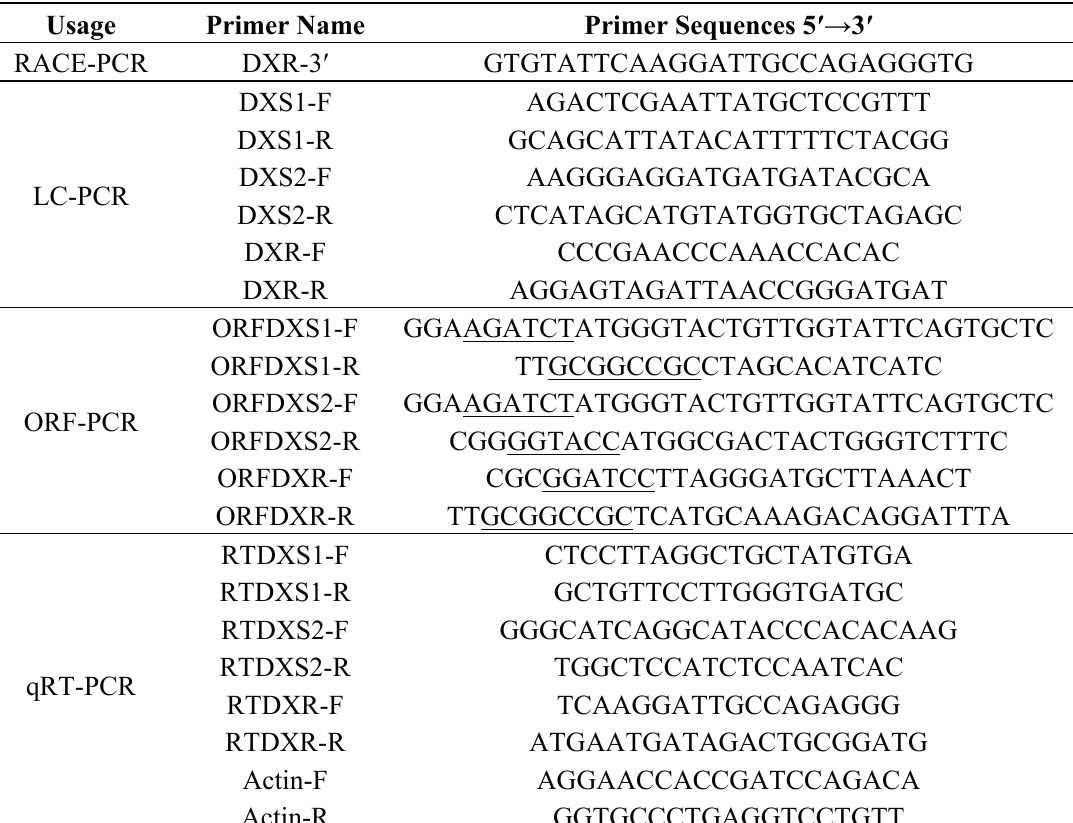
Table 2. Primers used in this